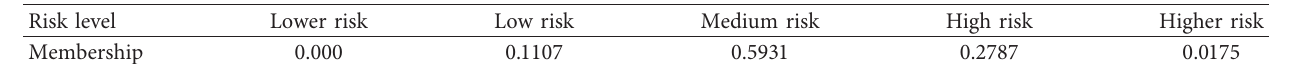
Table 12: Evaluation results of the Donghu Deep Tunnel